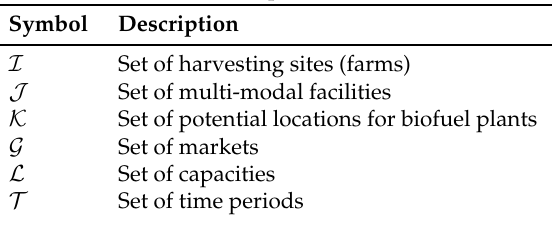
Table 1. Description of the